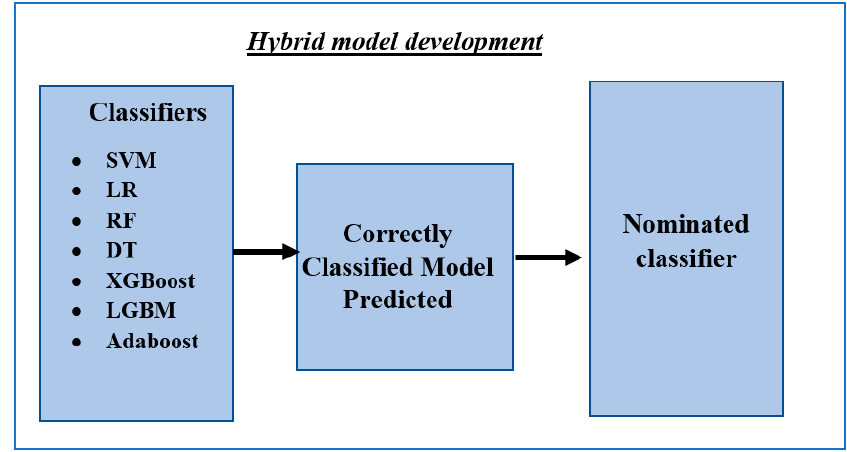
Figure 6. Flowchart of the proposed model. Table 2. Comparison between different algorithms’ strengths and